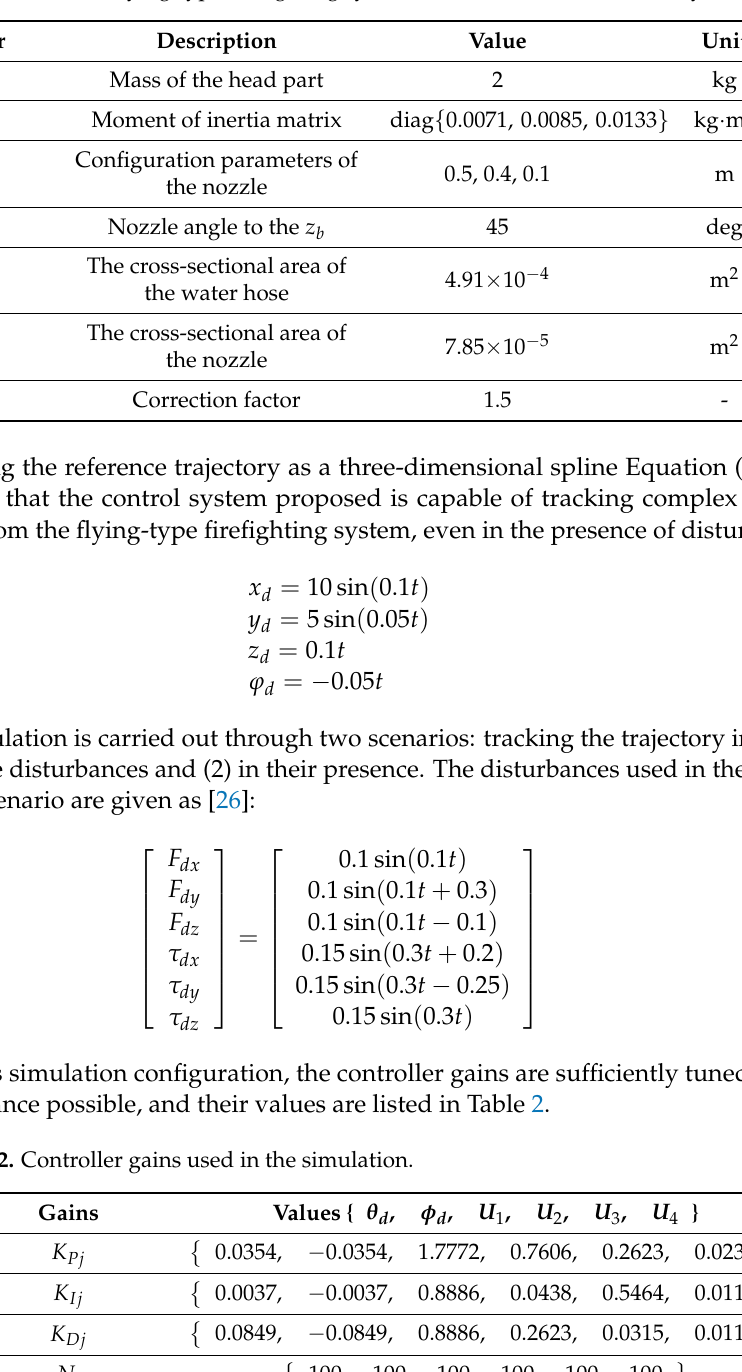
Table 1. Parameters of the flying-type firefighting system used in the simulation study.